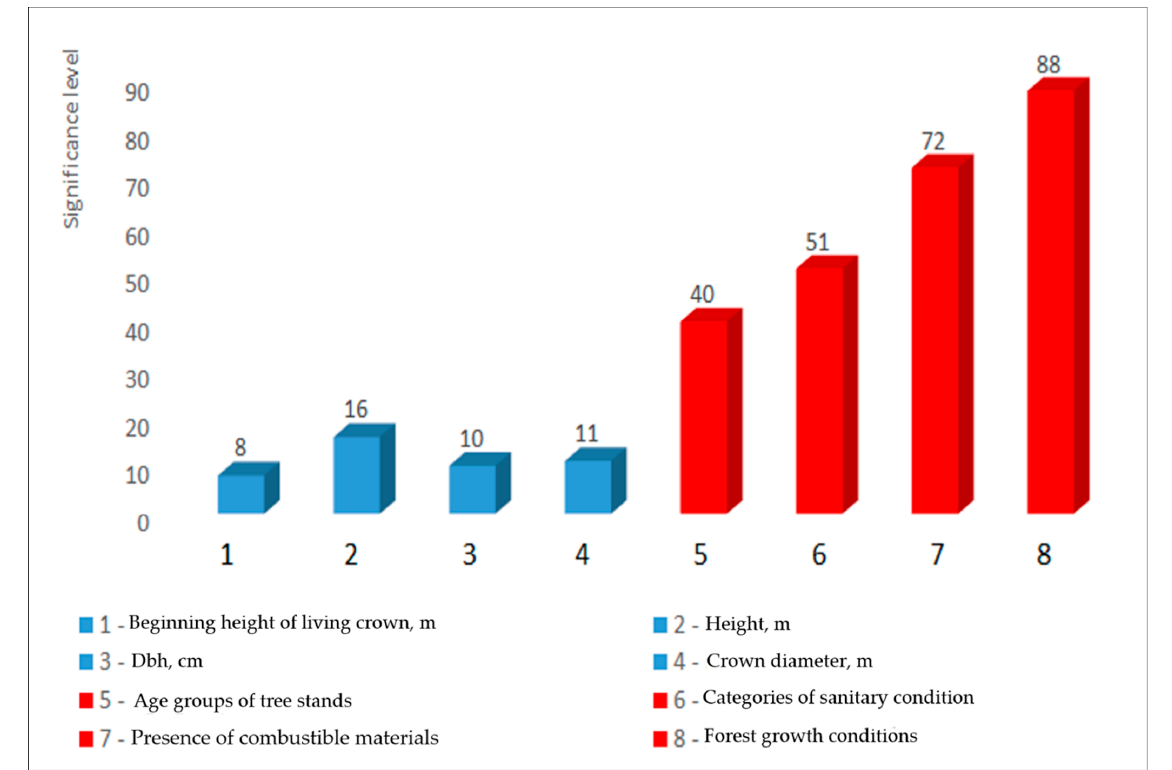
Figure 4. Significance levels of the main taxation characteristics relative to burning index.